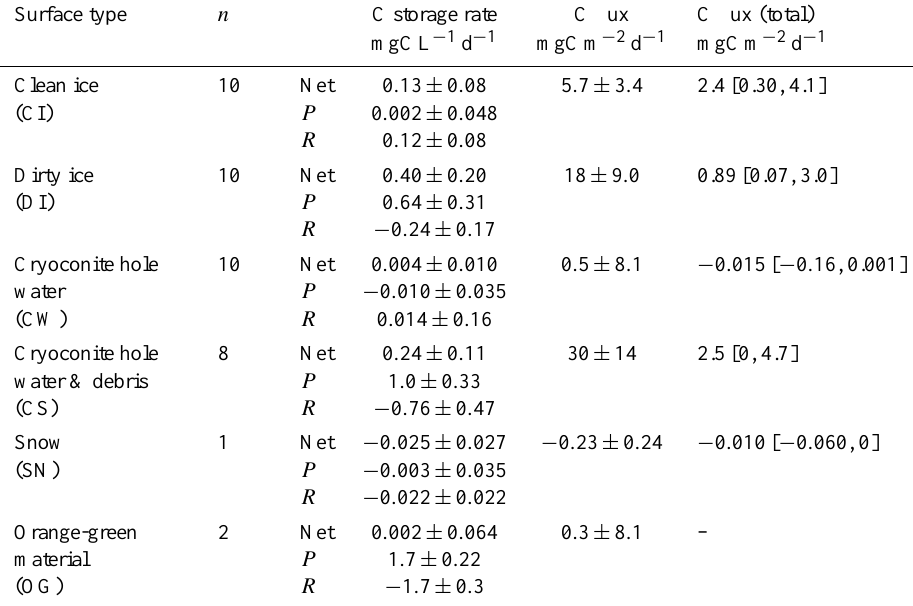
Table 3. Summary of productivity data for the regular ( ∼ weekly) incubation experiments, presented as mean ± 1 σ of carbon storage rates in n incubation experiments. P , R and net are results for inferred photosynthesis only, inferred respiration only, and both processes combined. C storage is the carbon storage rate in the bottle. C flux is the seasonal mean of C storage when converted to carbon flux, based on the surface area sampled to fill the bottle; C flux (total) is the C flux weighted by the fractional surface area of that type, with [5, 95%] percentiles of 66 interpolated daily values. Observation periods for productivity were 4 June–8 August 2012 except snow (9 June only) and orange-green material (4 and 9 July only).